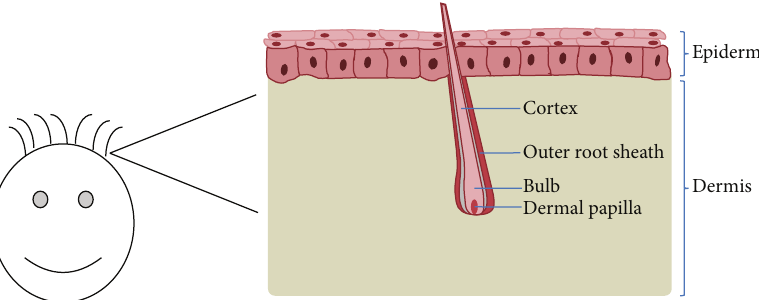
Figure 2: Structure of a hair follicle embedded in skin. Human plucked scalp hair lies in the dermis. Under culture conditions, keratinocytes will grow out of the outer root